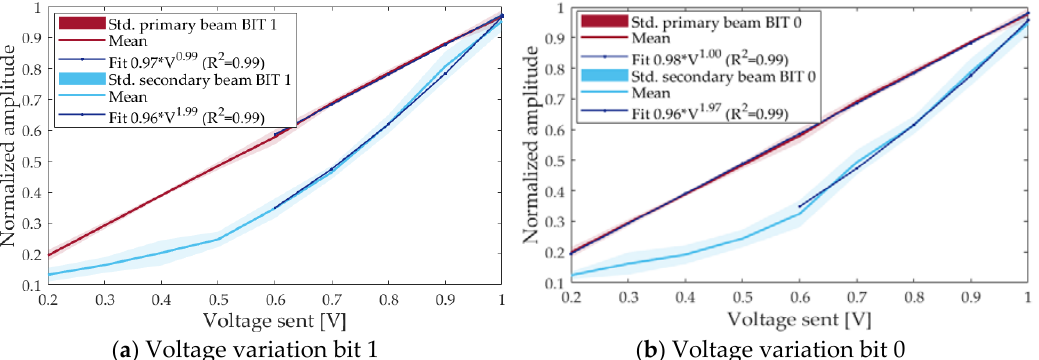
Figure 7. Normalized amplitude of the received signal for primary beam (red) and secondary beam (blue) as a function of voltage sent of emitted signal (i.e., feeding voltage before the amplifier). Std. means the standard deviation. ( a ) for bits 1; ( b ) for bits 0.